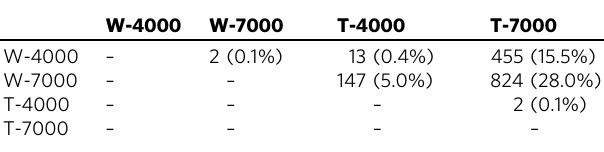
Numbers indicate the number of genes whose expression levels were signi fi cantly different between the two conditions among 2942 genes ( q value<0.05). The numbers in parenthesis indicate the percentage of the identi fi ed genes of the 2942